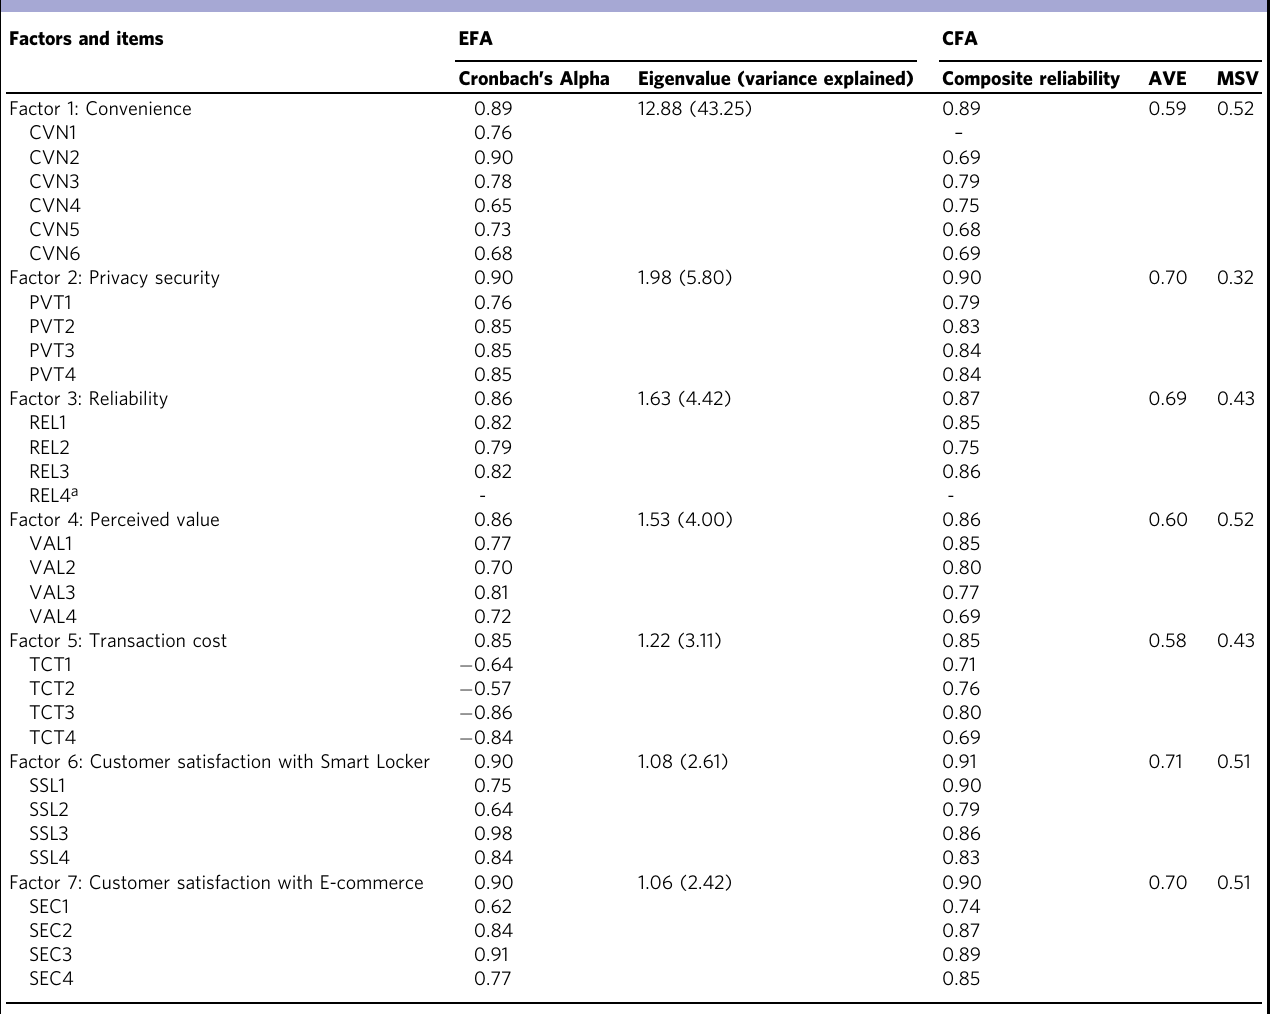
Table 5 Cronbach ’ s alpha, EFA, and CFA results. Factors and